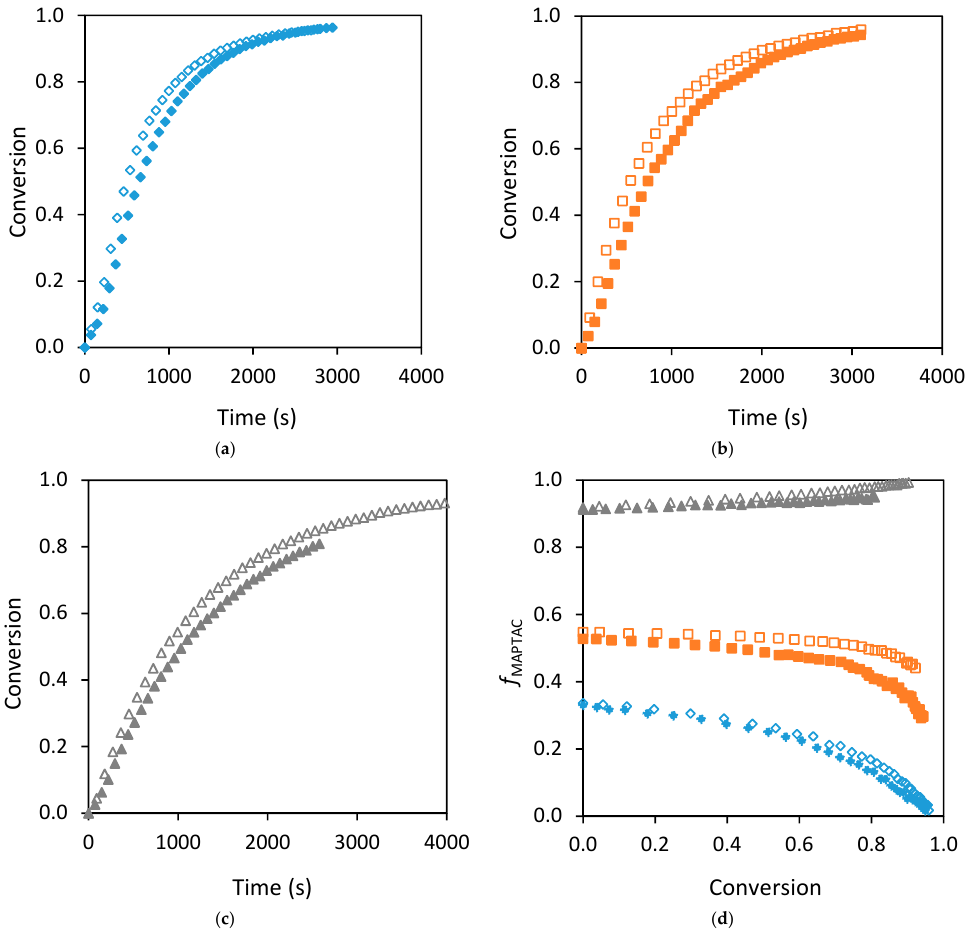
Figure 5. Overall monomer conversion profiles for AA-MAPTAC copolymerization with f MAPTAC,0 of ( a ) 0.3 ( b ) 0.5 and ( c ) 0.9 at 50 °C, 0.80 wt% V-50, and w mon.0 = 0.10 without NaCl (open symbols) and with 1.0 mol · L − 1 NaCl (closed symbols). The corresponding comonomer composition drifts are shown in ( d ) as a function of overall monomer